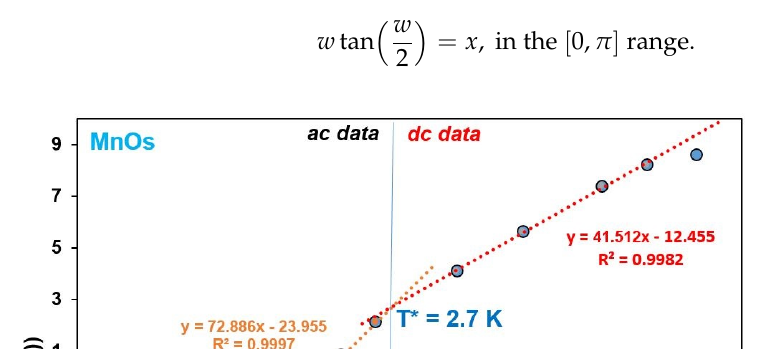
Table 2. Single chain magnet related parameters for 1 , 2, and their Fe congener [77] (in K if not specified). Chain J/ cm − 1 Jx, Jy, Jz/ cm − 1